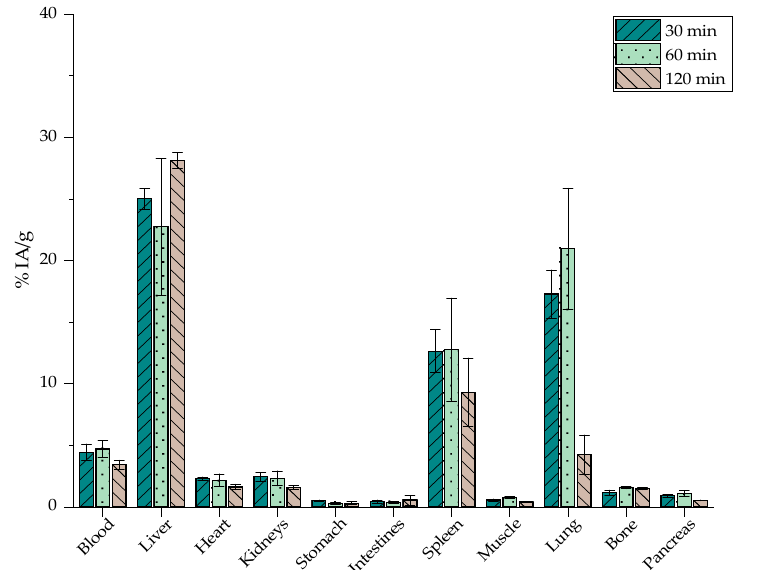
Figure 12. Biodistribution of [ 68 Ga]Ga-MA in normal mice expressed as % IA/g ( n = 3). The biological behavior of [ 68 Ga]Ga-MAPEG is depicted in Figure 13, where an augmented liver and spleen uptake is obvious at 30 min p.i. (31.92 ± 5.04% and 18.43 ± 1.93%) followed by a decreasing pattern and reaching 22.99 ± 4.94% and 14.23 ± 1.65%, respec- tively, at 2 h p.i.